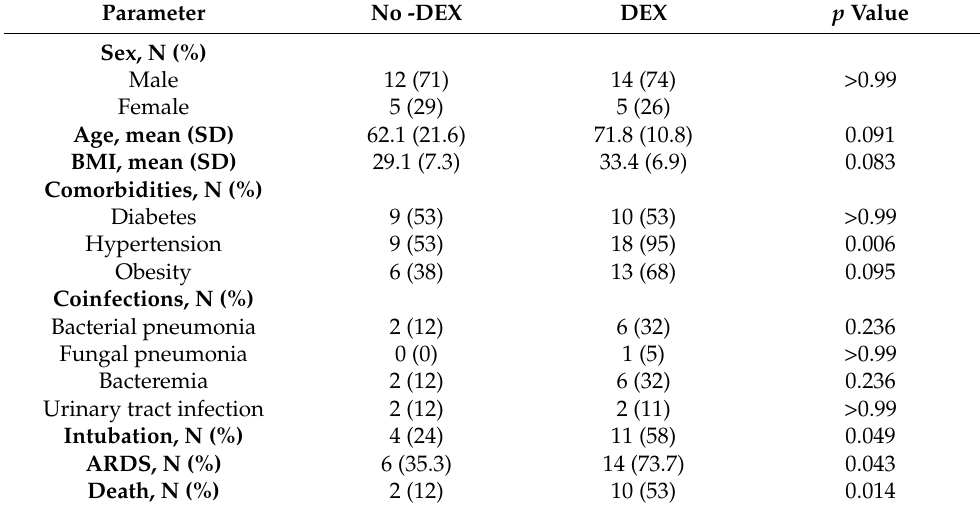
Table 1. Patient